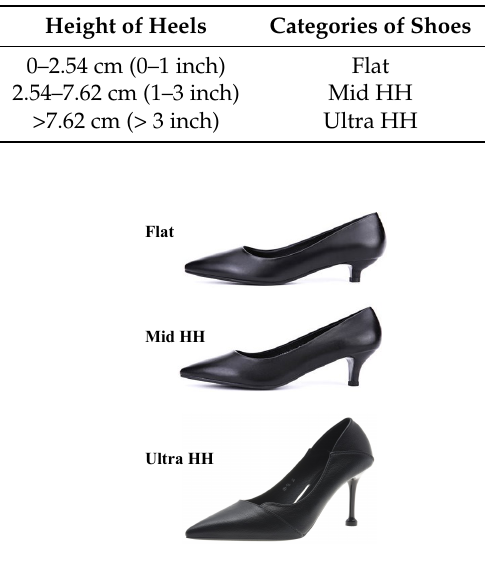
Table 1. Categorizations of shoes.